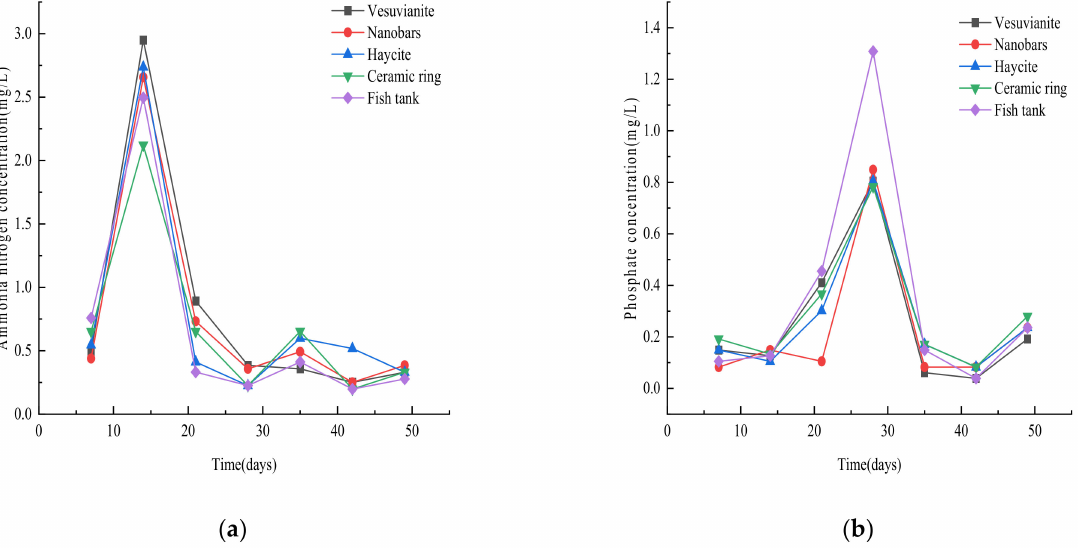
Figure 2. Variation in ( a ) ammonia nitrogen and ( b ) phosphate mass concentration in each filter tank and the fish